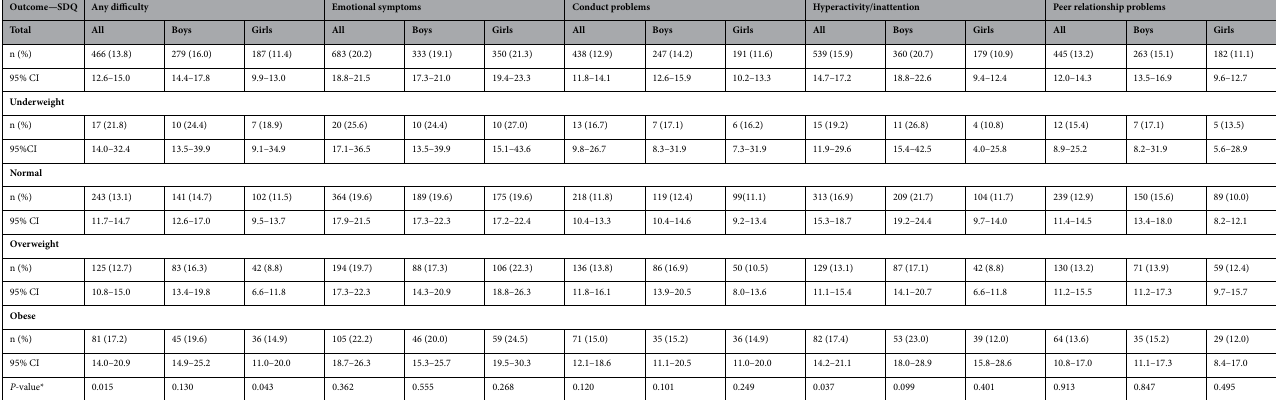
Table 2. – Prevalence of mental health problems (with 95% confidence interval) according to maternal pre- pregnancy body mass index, among 11-year-old children. * P -value: X 2 test.